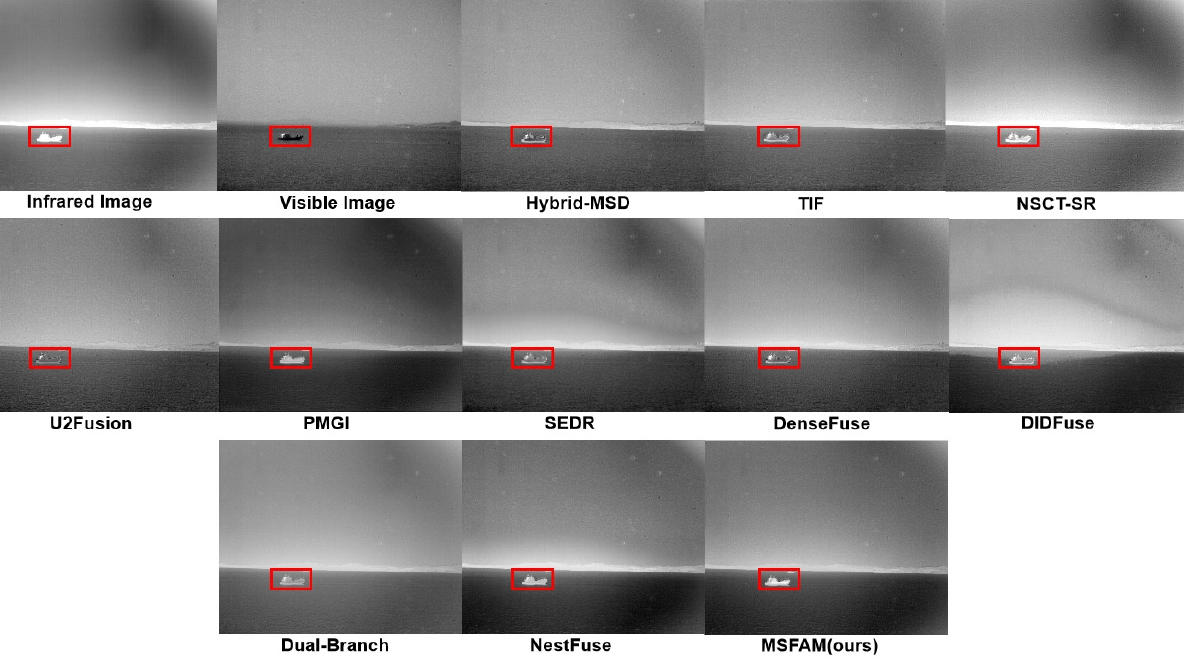
Figure 8. Experimental results of various methods on the “ship” images. Red square represents for the areas that need to be focused.